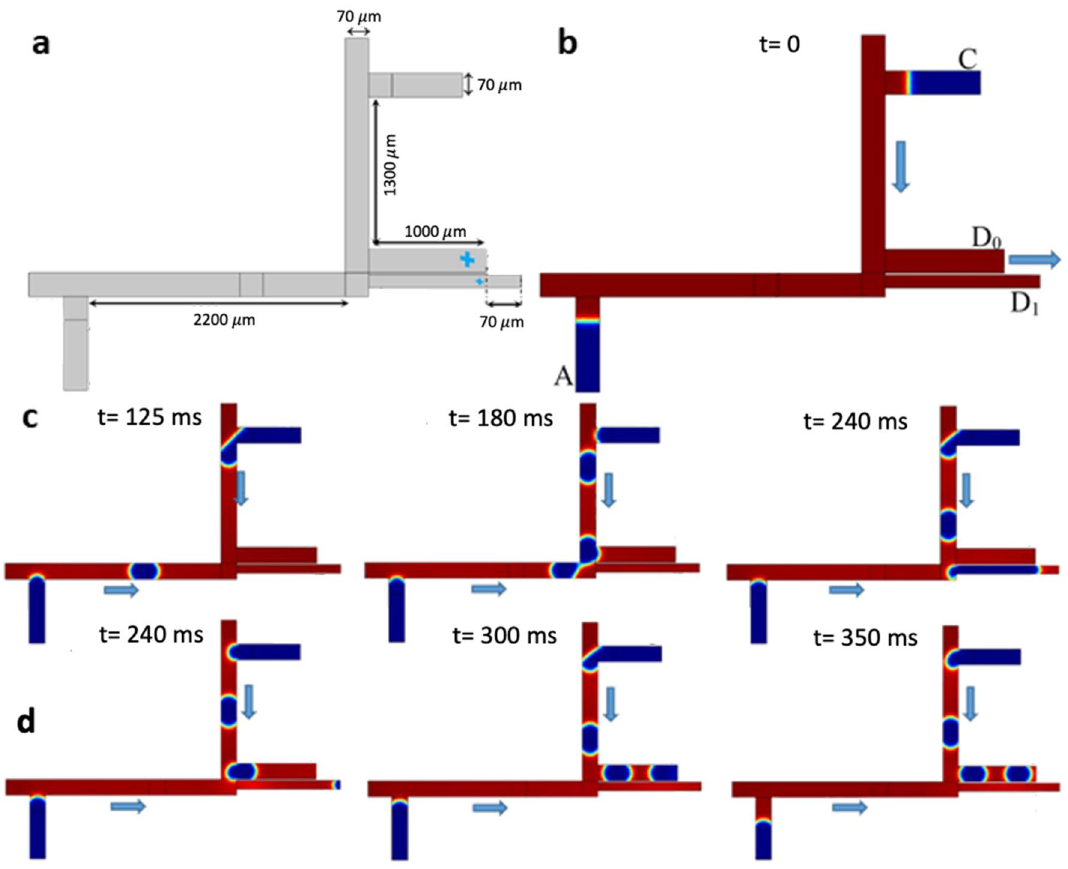
Figure 10. The microfluidic Decoder 1 to 2 circuit. (a,b) The design and geometry of the Decoder 1 to 2 circuit. (c) A snapshot of the case (0–1), in which only input C produces bubbles to show the asynchronous function of Decoder 1 to 2 and the direction of the bubble flow is toward the output D 0 . (d) Series of snapshots of the function of the case (1–1) where the direction of bubble flow is toward output D 1